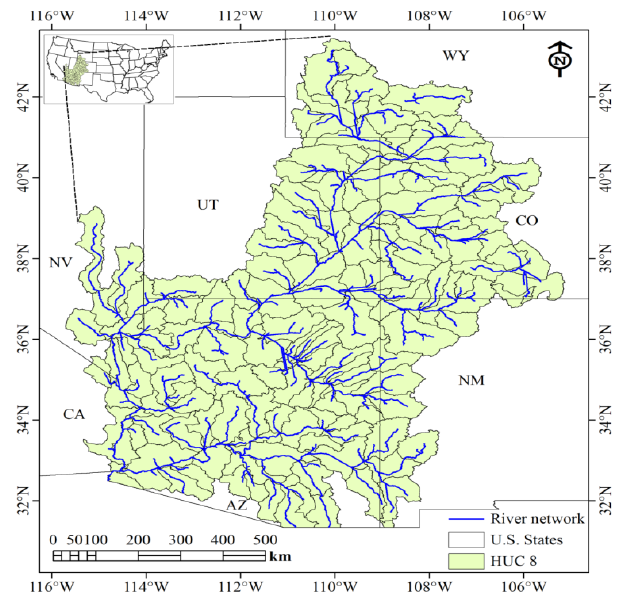
Figure 1. Location of the study area showing the Colorado River